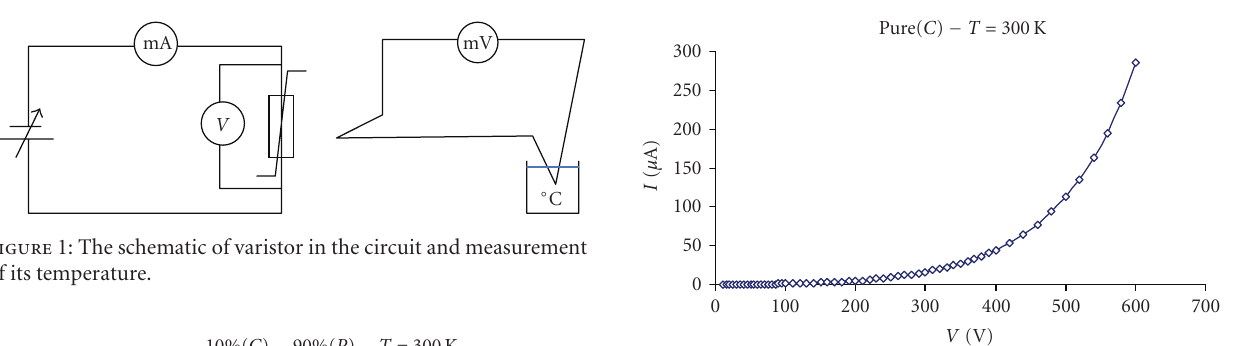
Figure 3: The I-V characteristic for sample no.5 at room tempera- ture.